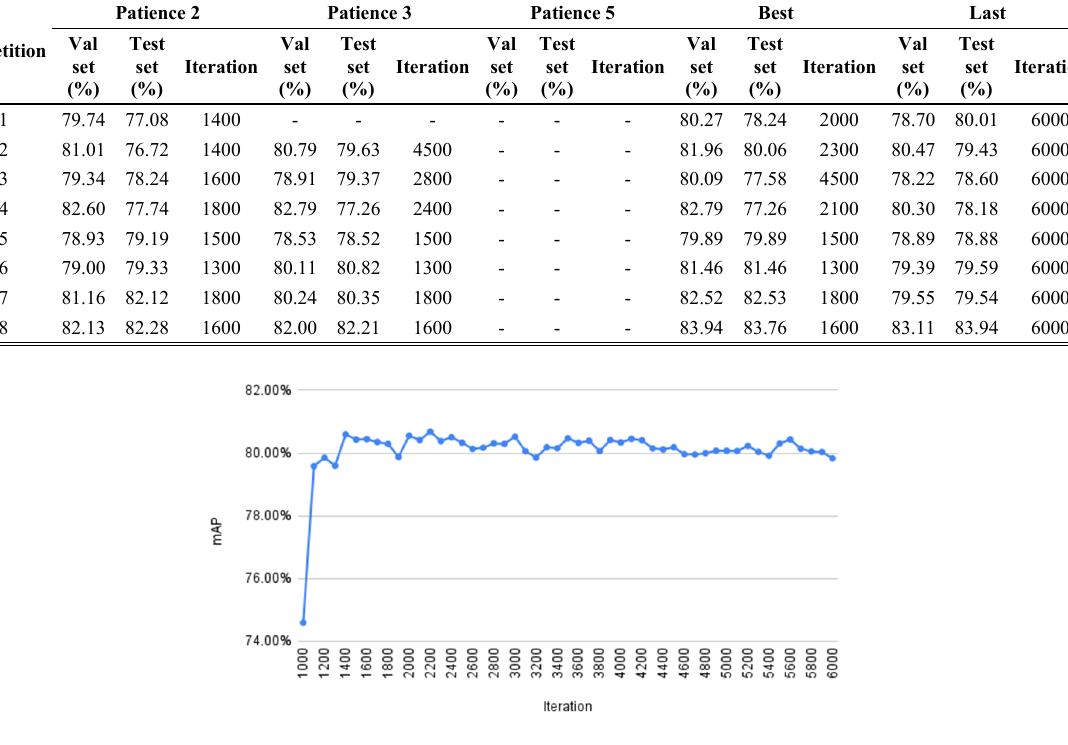
TABLE 7 S UMMARY OF M AP OBTAINED FROM THE RESULTS OF THE BALL DATASET EXPERIMENT